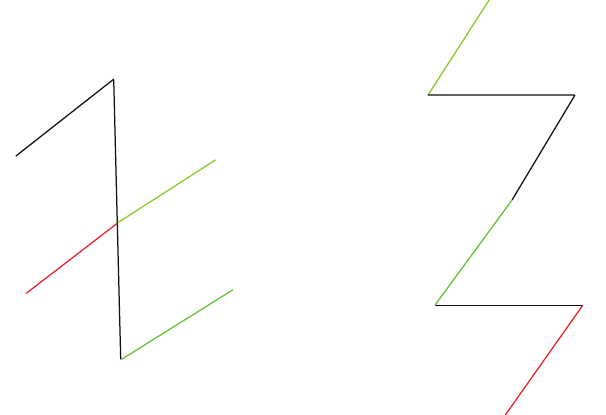
Figure 3: A multiple Z-plasty.